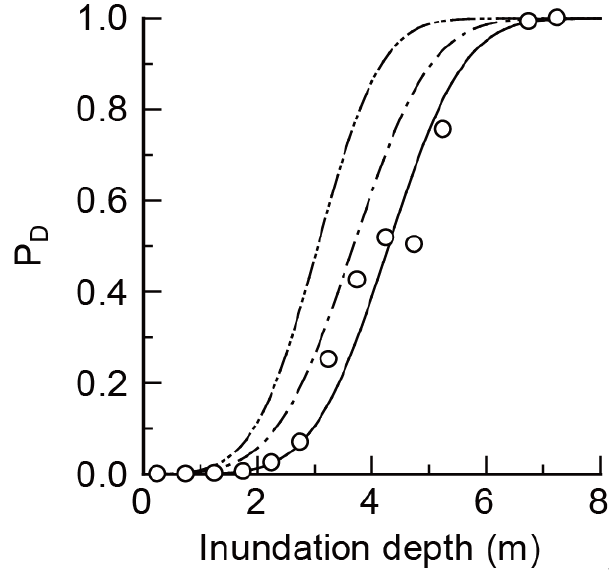
Figure 14. Fragility functions for building loss in Sendai City. The solid curve was obtained by fitting Equation (4) to observed building damage data. The dash–single dot curve represents the function when µ = 3.57 and σ is represented by Equation (6), for washed away buildings, and the dash–double dot curve represents the function when μ = 3.02 and σ is represented by Equation (6) plus 0.2 (the safe-side design fragility function for washed away buildings).